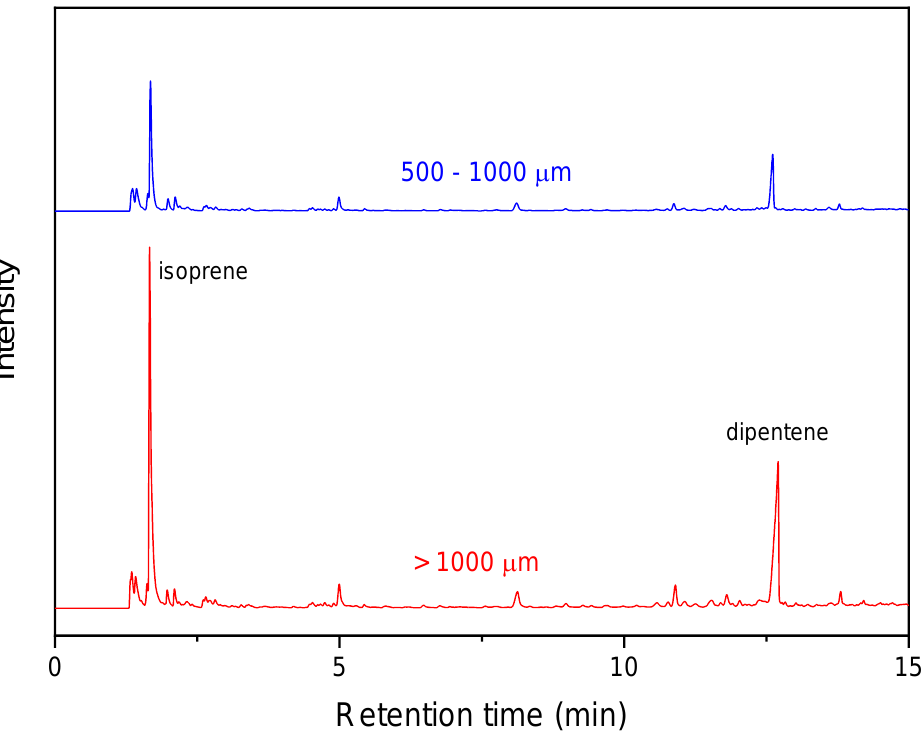
Figure 3. Py-GC chromatograms of the NR0 wear particles of 500 – 1000 and larger than 1000 μ m. 3.2. Variations of the Isoprene/Dipentene Ratios with the Wear Particle Size and Crosslink Density Variations of the isoprene/dipentene ratios with the wear particle size and crosslink density were examined (Figure 4). The isoprene/dipentene ratio exponentially increased as the wear particle size decreased. The ratio slightly increased until around 1.0 × 10 5 µ m 2 of the wear particle size and then steeply increased. The increased ratio of isoprene/dipentene with a decrease in the wear particle size can be explained by a difference in the heat